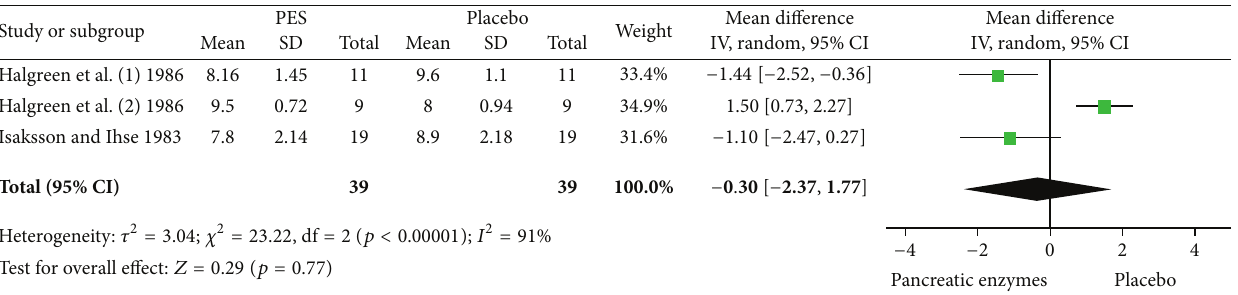
Figure 5: Random model meta-analysis of the average analgesic consumption per week in two crossover studies ( 𝑛 = 39